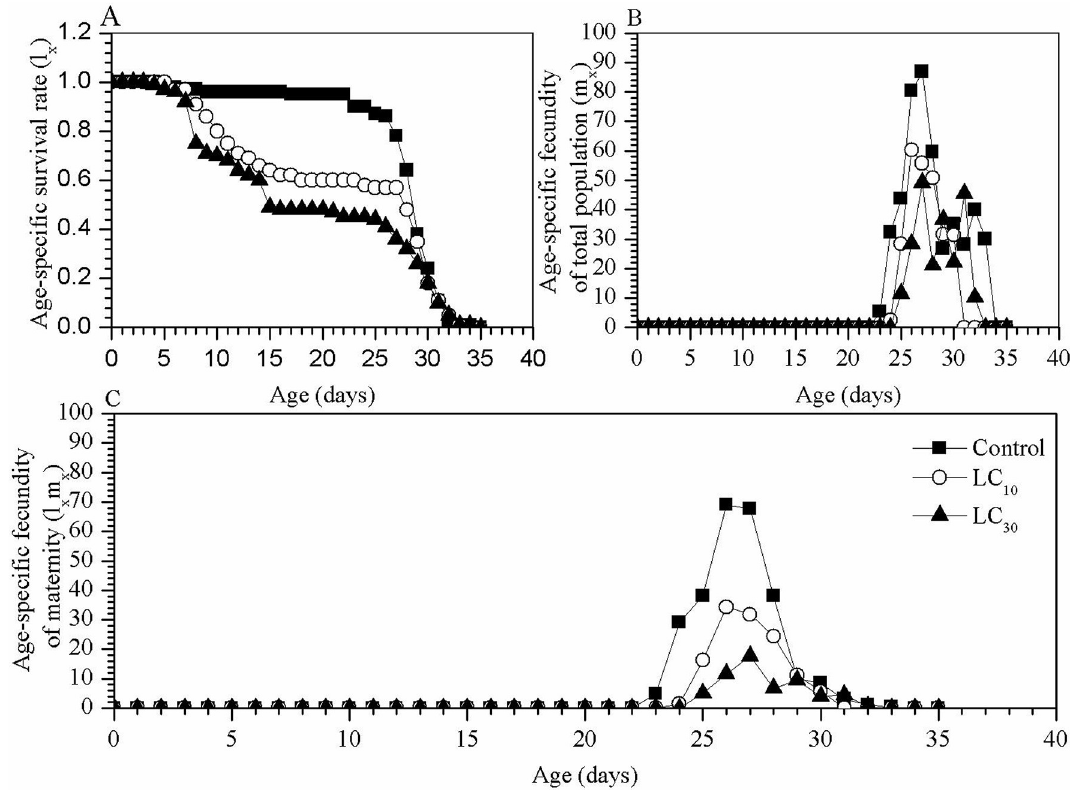
Fig 3. Effects of sublethal TCAP on the age-specific survival rate and population fecundity. A, age-specific survival rate curve ( l B, age-specific curve of the fecundity of the total population ( m x ); and C, age-specific maternity curve ( l x m x ) for S . exigua .